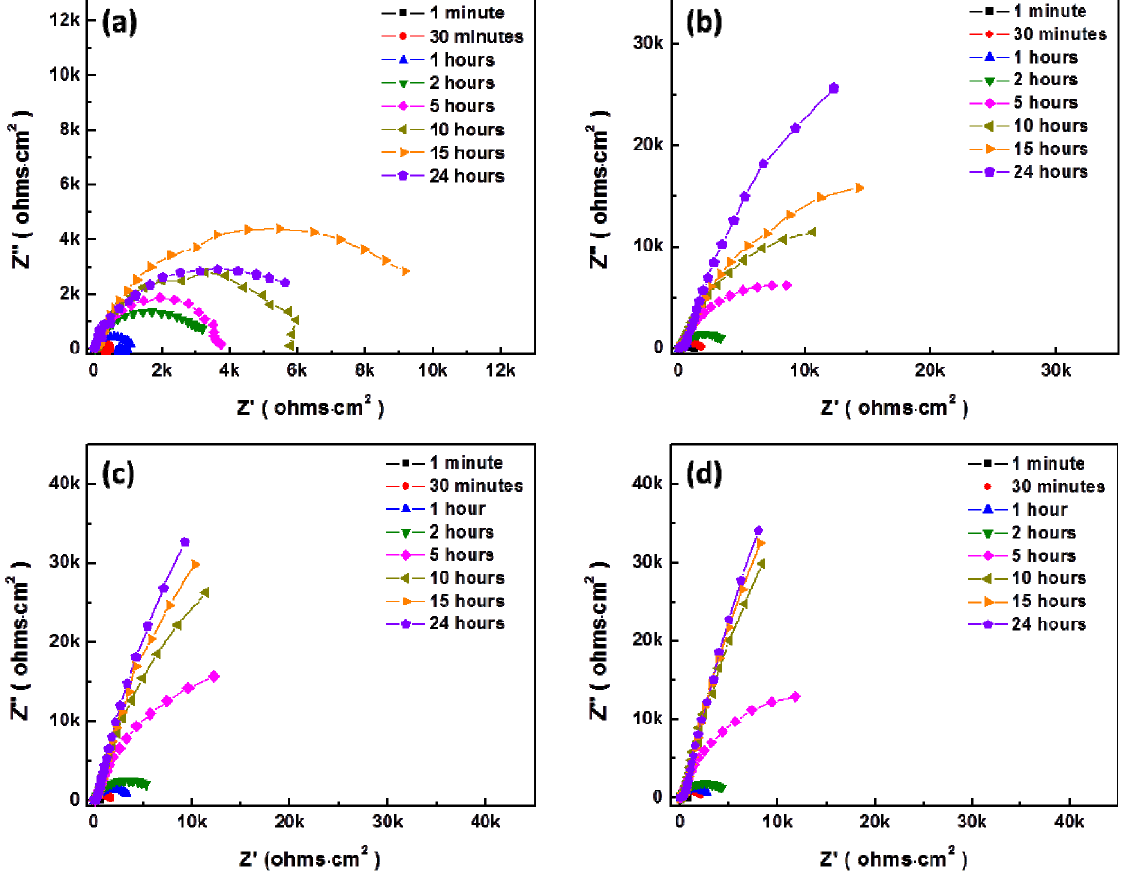
) by corrosion products and c ) for AZ31 magnesium alloys during immersion in t